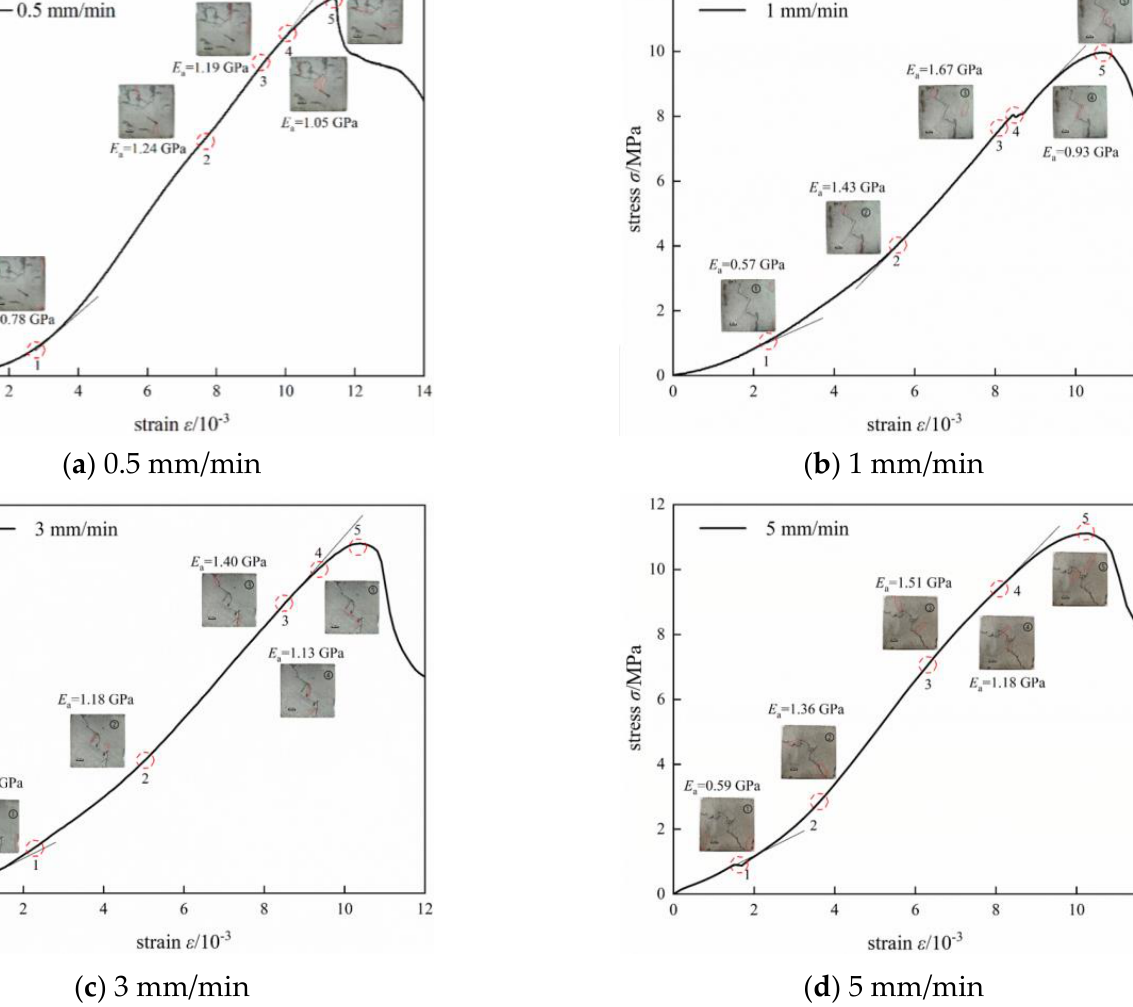
Figure 6. Correspondence relationship between crack propagation and stress – strain curve of typical Figure 6. specimen.